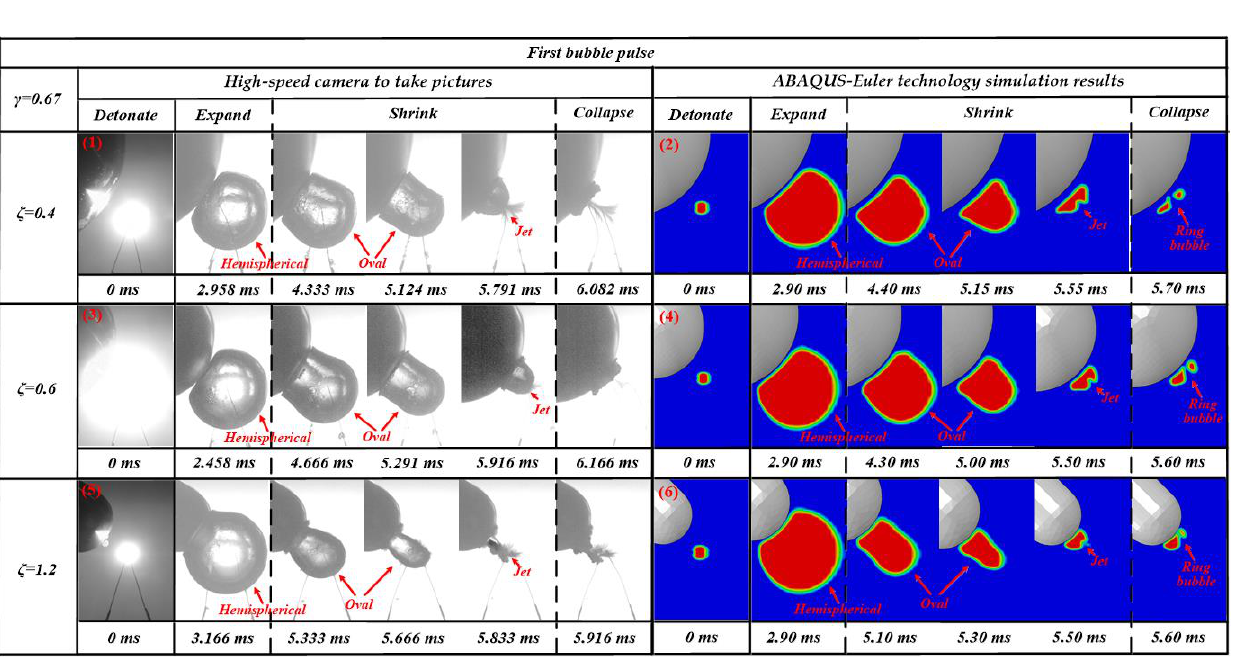
Figure 14. Comparison of experimental results and simulation results. ( 1 ) The pulsation diagram of the first cycle of the bubble taken by a high-speed camera when ζ = 0.4 and γ = 0.67. ( 2 ) The pulsation diagram of the first cycle of the bubble simulated by ABAQUS/Explicit when ζ = 0.4 and γ = 0.67. ( 3 ) The pulsation diagram of the first cycle of the bubble taken by a high-speed camera when ζ = 0.6 and γ = 0.67. ( 4 ) The pulsation diagram of the first cycle of the bubble simulated by ABAQUS/Explicit when ζ = 0.6 and γ = 0.67. ( 5 ) The pulsation diagram of the first cycle of the bubble taken by a high-speed camera when ζ = 1.2 and γ = 0.67. ( 6 ) The pulsation diagram of the first cycle of the bubble simulated by ABAQUS/Explicit when ζ = 1.2 and γ = 0.67.